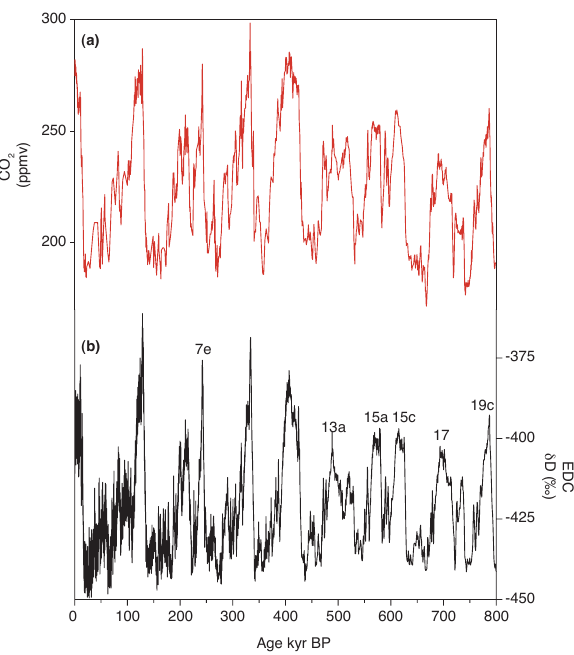
Fig. 11. Relative intensities of the “cooler” interglacials on the ba- sis of their peak values in Antarctic temperatures and CO 2 concen- trations. (a) atmospheric CO 2 concentration in Antarctic ice cores (L¨uthi et al., 2008); (b) δ D composition of ice in the EDC ice core (Jouzel et al., 2007). Records are plotted on the EDC3 timescale of Parrenin et al.